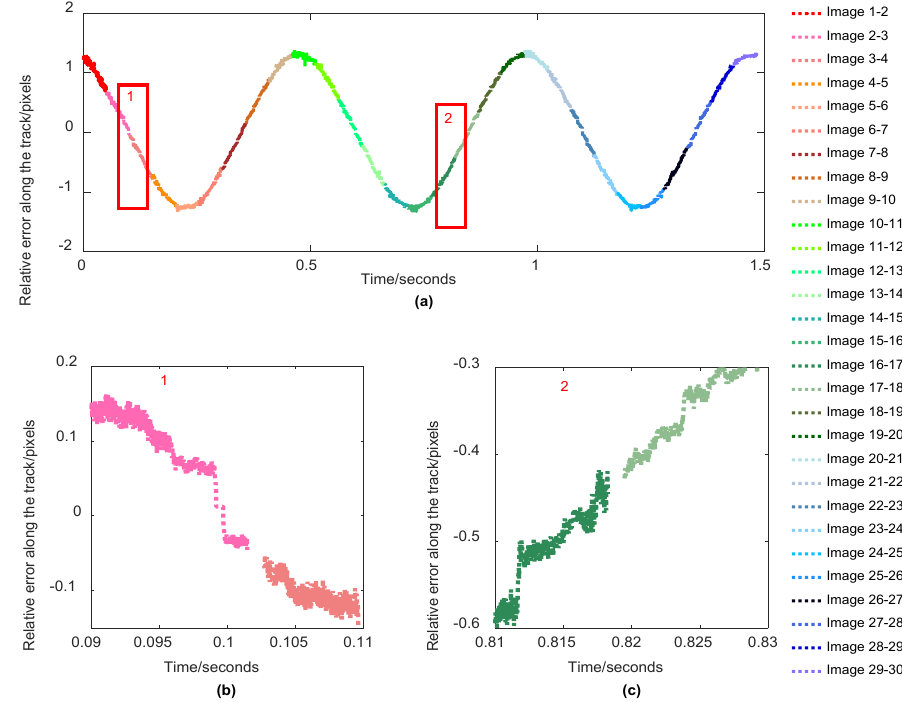
Figure 10. The 2-Hz jitter detection curves by sequential disparity maps. ( a ): The whole detected results; ( b ): The local amplification of rectangular area 1 in ( a ); ( c ): The local amplification of rectangular area 2 in ( a ).